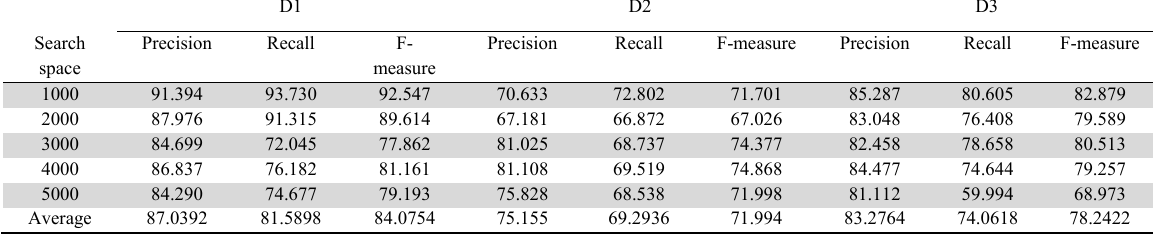
Performance of GARC (macro average %) for each dataset based on the top ranked features using TF-IDF D1 D2 D3 Search Precision Recall F- Precision Recall F-measure Precision Recall space measure